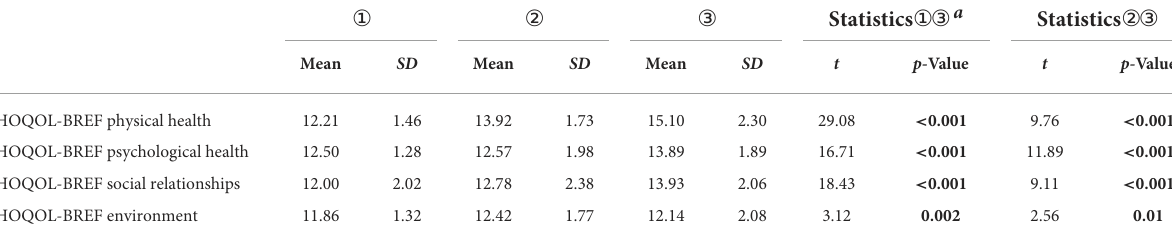
TABLE 3 Comparison of QoL between schizophrenia patients (at baseline, after 2 years) and the general Chinese